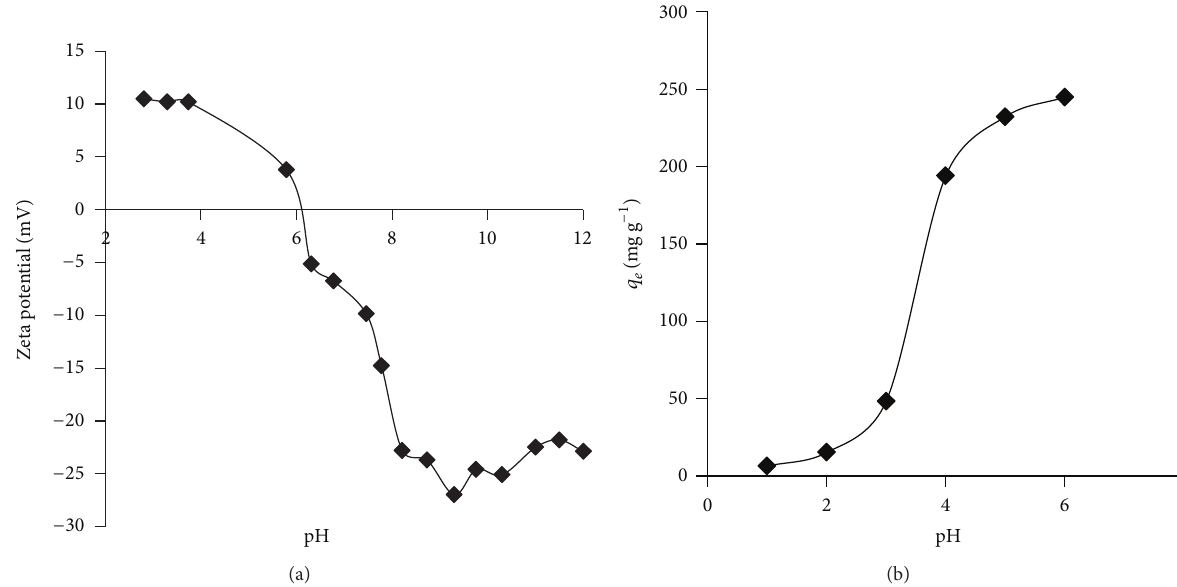
Figure 1: (a) Zeta potentials of SAC2 as a function of pH, (b) effect of pH for the adsorption of lead (II) ions onto the activated carbon (SAC2). ( C 𝑜 = 300 mgL −1 ; 𝑚 = 50 mg; 𝑉 = 100 mL; 𝑇 = 25 ∘ C; agitation rate 200rpm).